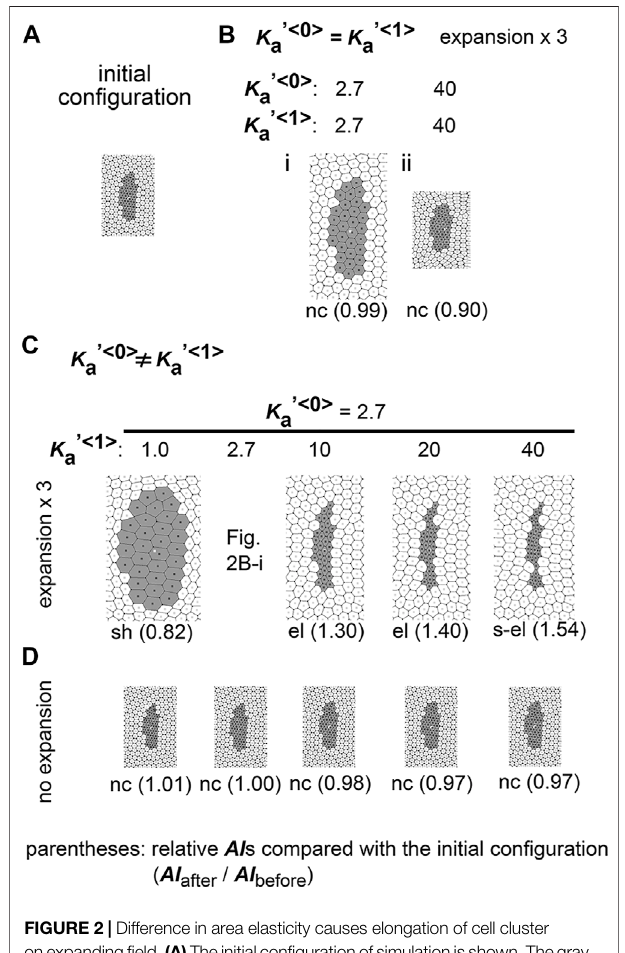
C are shown except that the fi elds were not expanded (no expansion). The scales of these images are the same as those in C. The relative AI s are shown with the morphological categories. Simulation results obtained using different area elasticity values are provided in Supplementary Figure S2 .